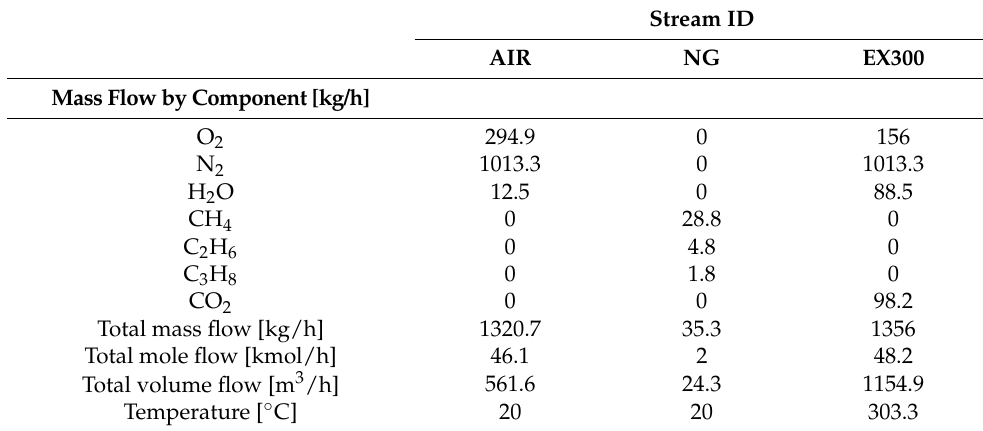
Table 6. Inlet and outlet streams of a 300 kW SOFC system.